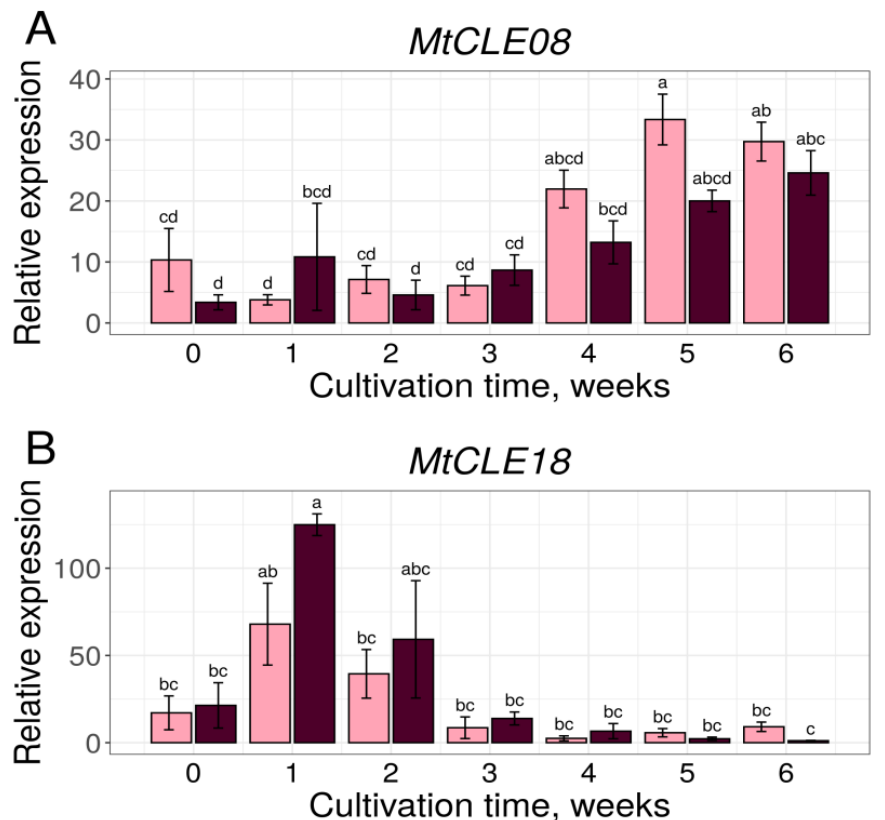
Figure 4. MtCLE08 ( A ) and MtCLE18 ( B ) genes expression dynamics during in vitro cultivation of explants of embryogenic 2HA (pink) and non-embryogenic A17 (dark-red) lines. Error bars represent the standard error. Data are obtained from three biological replicates. To assess the statistical significance of the observed differences, one-way analysis of variance (one-way ANOVA) with Tukey’s post hoc test was used, with confidence level 0.95. Different lowercase letters represent expression levels with statistically significant differences ( p -value < 0.05).